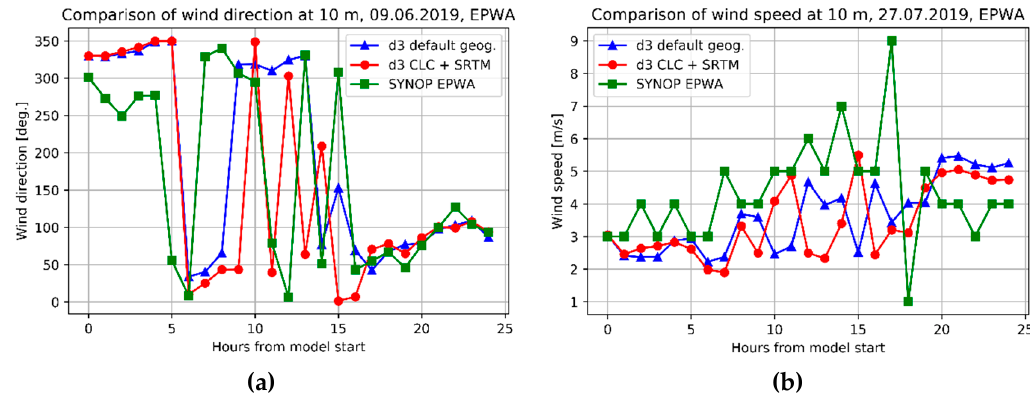
Figure 9. ( a ) Example of the obtained values of wind direction at domain 3 for the EPWA, 09.06.2019; ( b ) example of the obtained values of wind speed at domain 3 for the EPWA, 27.07.2019.